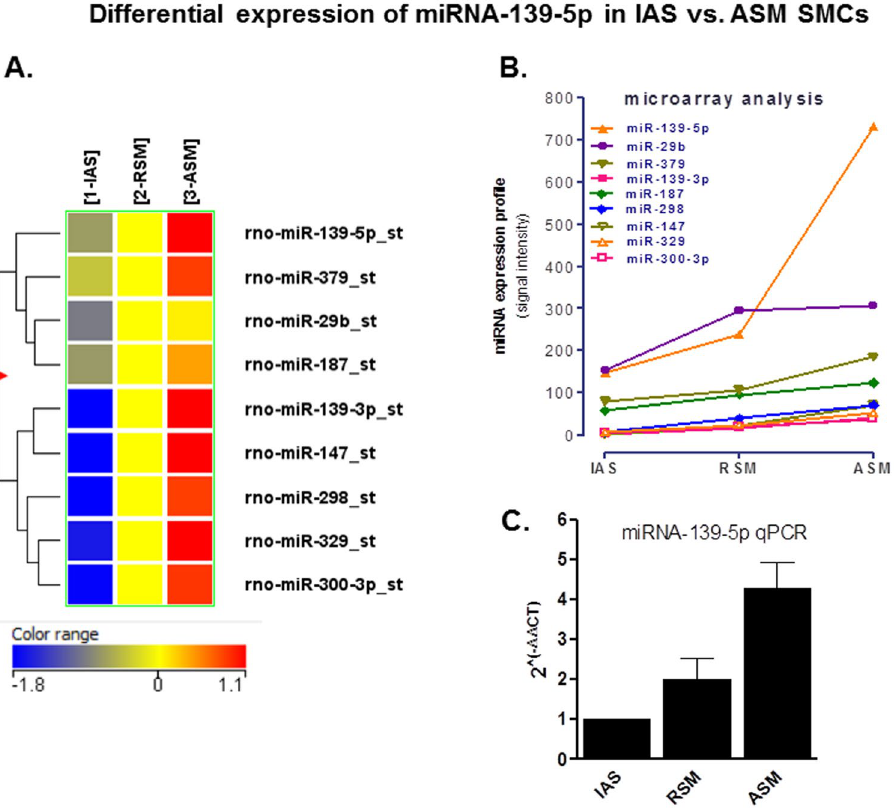
Figure 1. miRNA microarray data and its validation via qPCR. ( A ) Microarray analysis heat map of microRNAs isolated form rat IAS, RSM and ASM SMCs. Nine miRNAs shown in the heat map follow the gradient trend of ASM > RSM > IAS. ( B ) Graph showing that miRNA microarray identified nine differentially expressed miRNAs in an ascending gradient manner from the purely tonic, mixture of tonic and phasic to the purely phasic SMCs as IAS > RSM > ASM. The IAS represents tonic, while RSM and ASM represent semi tonic and purely phasic smooth muscles, respectively. Among nine differentially expressed miRNAs, miRNA-139-5p is the most differentially expressed, with ~4-fold higher expression in the ASM vs. the IAS. ( C ) qPCR analysis graph showing relative expression calculated by using the equation: Δ Ct = Ct miRNA-Ct (RNU6B) and 2^( − ΔΔ CT) = 2^( −Δ Ct IAS, RSM, ASM −Δ Ct IAS) confirms the highest expression of miRNA-139-5p in the ASM vs. the IAS SMCs with pattern similar to that in the differential miRNA microarray ( * p < 0.05; n =